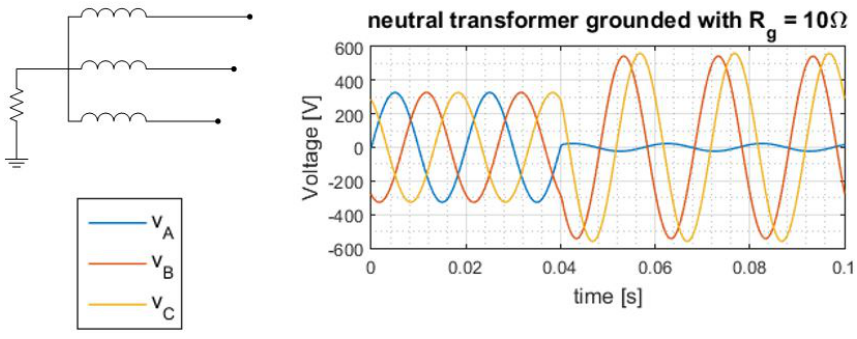
( b ) Neutral transformer grounded with R = 10 Ω . Figure 10. Voltage at AC nanogrid’s central node during fault for different neutral trans- former grounding.